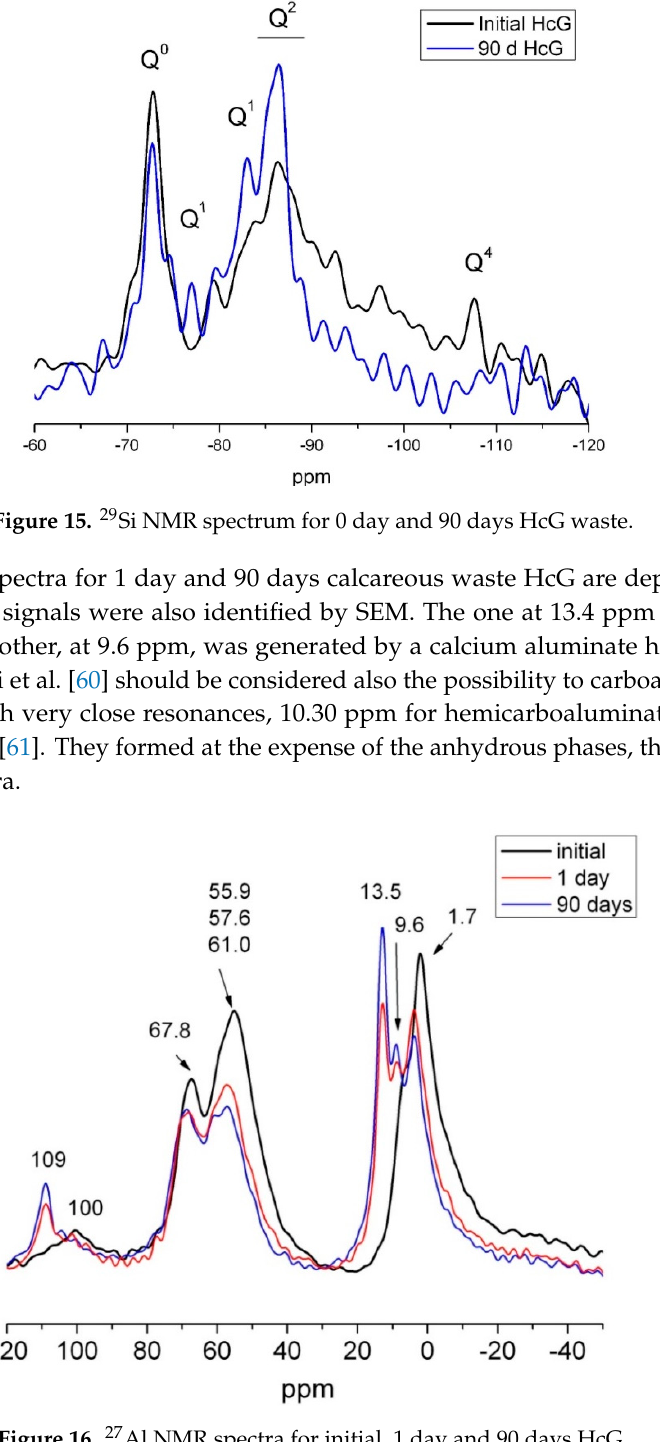
Figure 14. ( A ) Overview of HcG; ( B ) ettringite and C–S–H gel in HcG, detail; ( C ) overview of aggregates in HcC; ( D ) ettringite in HcC.